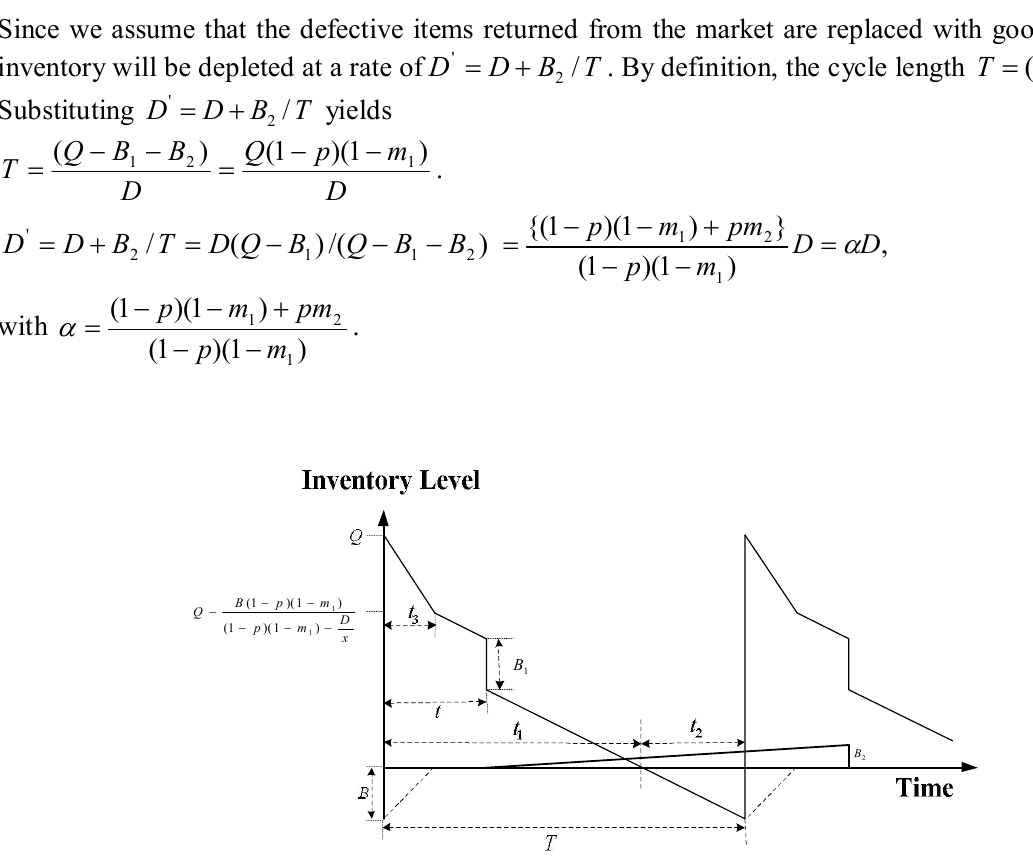
Fig. 1. Behavior of the inventory level over